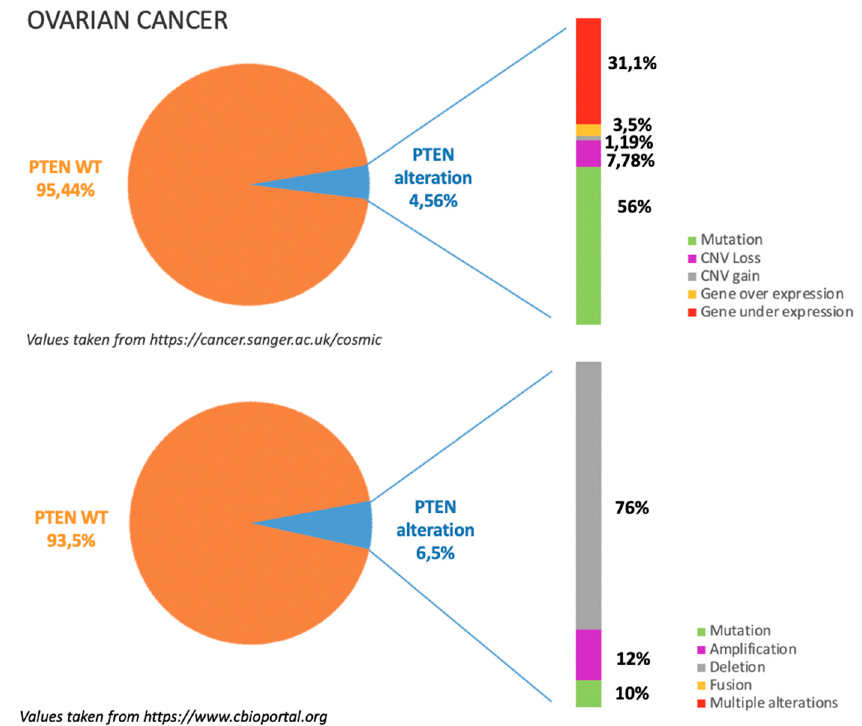
Figure 2. The incidence and type of PTEN alterations according to COSMIC and TGCA datasets in ovarian cancer.